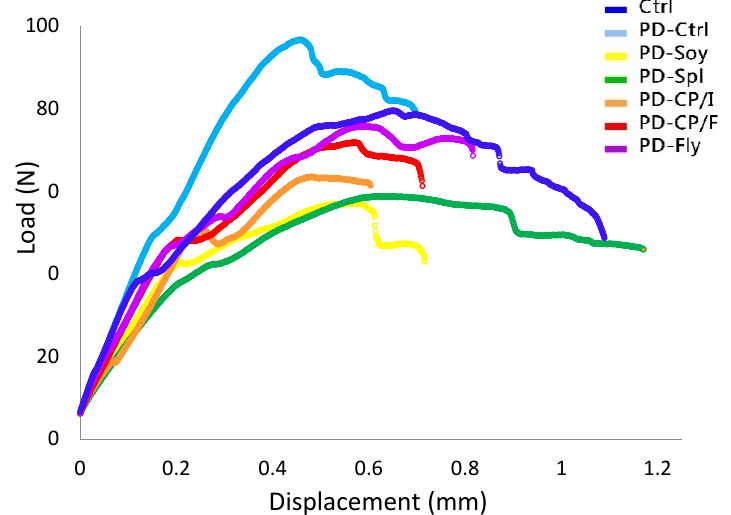
Figure 4. Force–Displacement curves of experimental groups. Mechanical properties were evaluated using a three-point bending experiment performed on the bones of all rats from the seven groups.